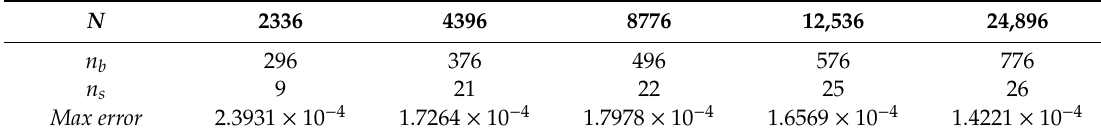
Table 5. Maximum absolute error for test 2 in case 4.